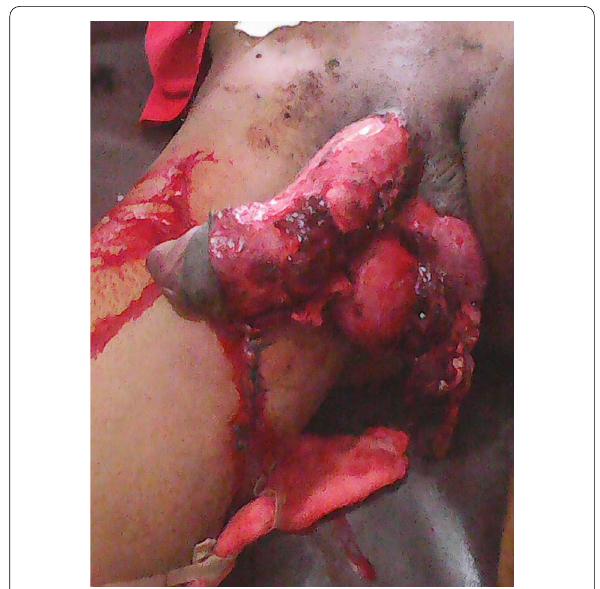
Fig. 1 Gunshot wound of the external genitalia with extensive penile and scrotal skin loss, ruptured anterior urethra, shattered left testis and sutured laceration of the medial aspect of the right upper